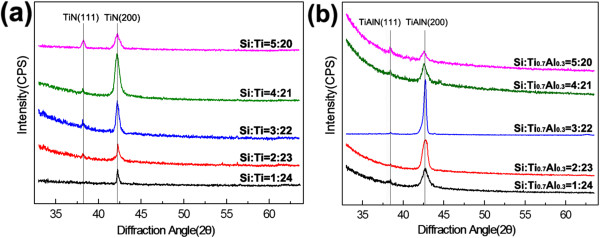
XRD patterns of (a) TiN/SiNx and (b) TiAlN/SiNx nanocomposite films with different Si content.